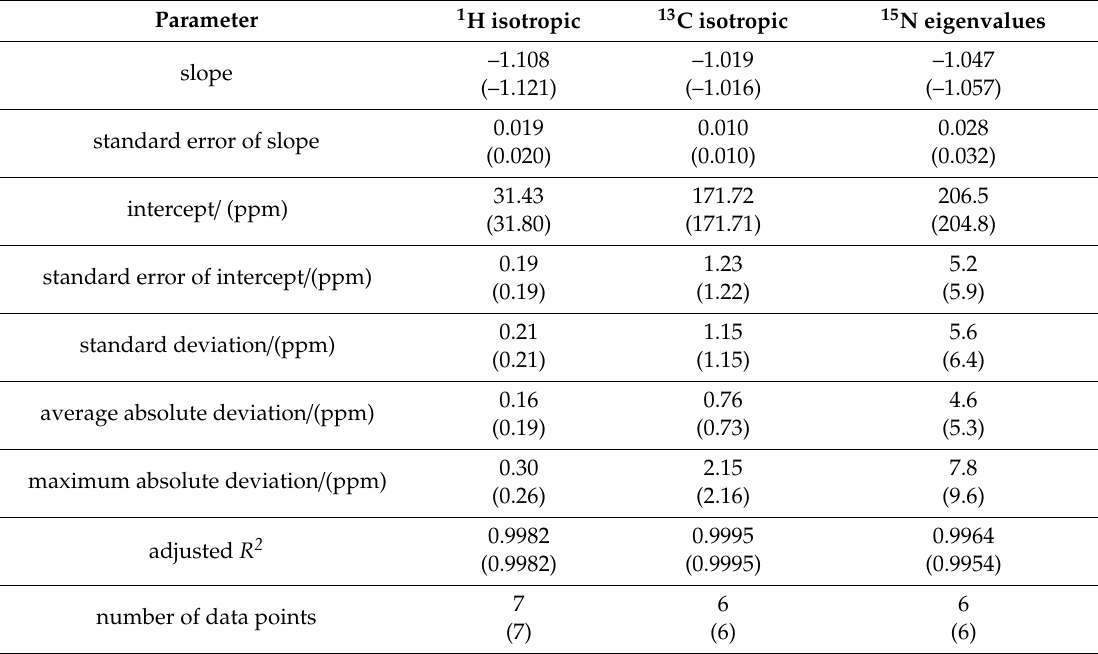
(cid:16) (cid:17) σ iso − σ di ff erences and ii